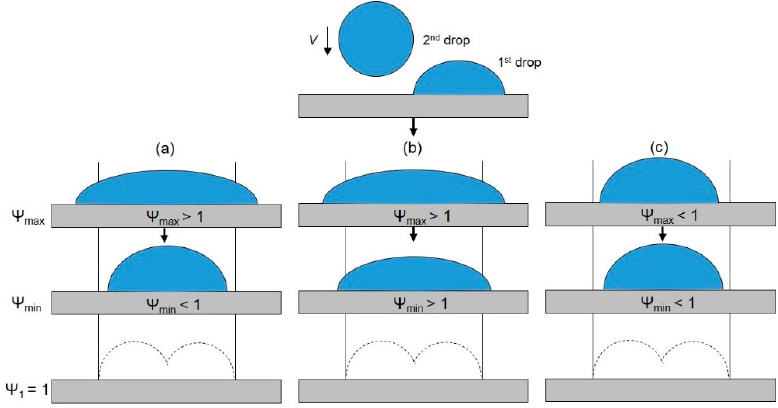
Figure 13. Schematic representation of coalescence mechanisms: ( a ) drawback due to retraction; ( b ) additional spread; ( c ) drawback not due to retraction.